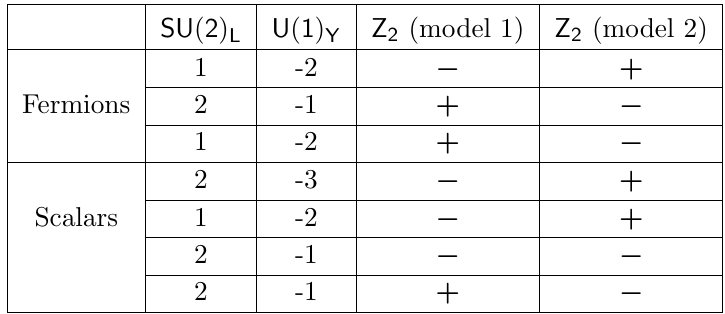
Table 26. The quantum numbers for a set of particles to exemplify the importance of Z 2 charge assignment: model 1 corresponds to assignment A while model 2 corresponds to B.